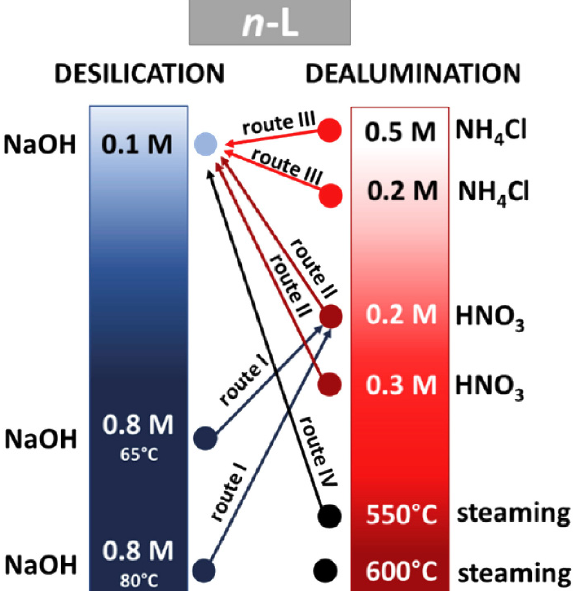
Figure 2. Various sequent post-synthetic treatment procedures of zeolite L. Reprinted with permission from [37] . Copyright 2017 Elsevier Inc.